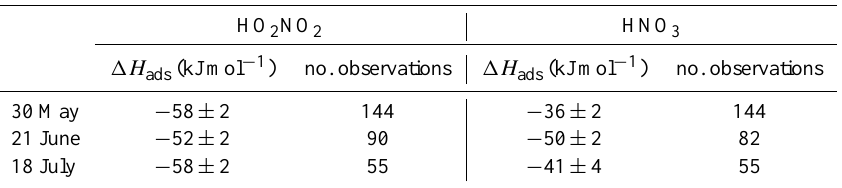
Table 2. The enthalpies of adsorption to ice for HO 2 NO 2 and HNO 3 as derived from three periods of the Halley measurements. The number of observations used for each derivation is also given. HO 2 NO 2 HNO 3 (cid:49)H ads (kJmol − 1 ) no. observations (cid:49)H ads (kJmol − 1